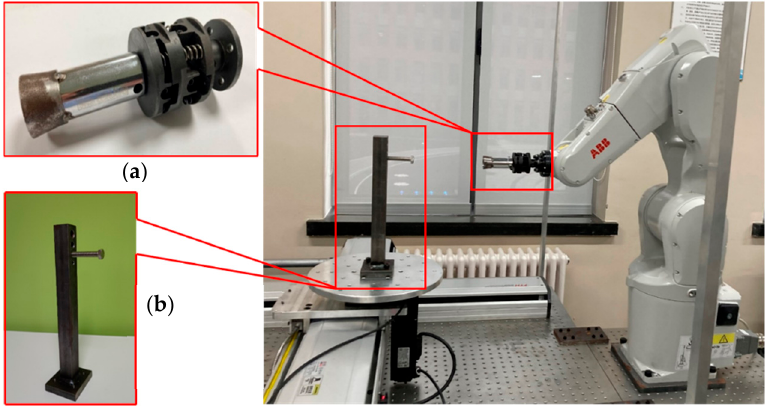
Figure 23. The test bench. ( a ) The universal wrench. ( b ) The fastening bolt simplification device. Taking the axis of the fastening bolt as the test benchmark, by adjusting the pose of the end effector of the cutter-changing robot, the docking conditions are set to no devia- tion, radial displacement deviation, and angular deviation, as shown in Figure 24. The size of the docking deviation is determined through the robot posture displayed on the robot operation panel.